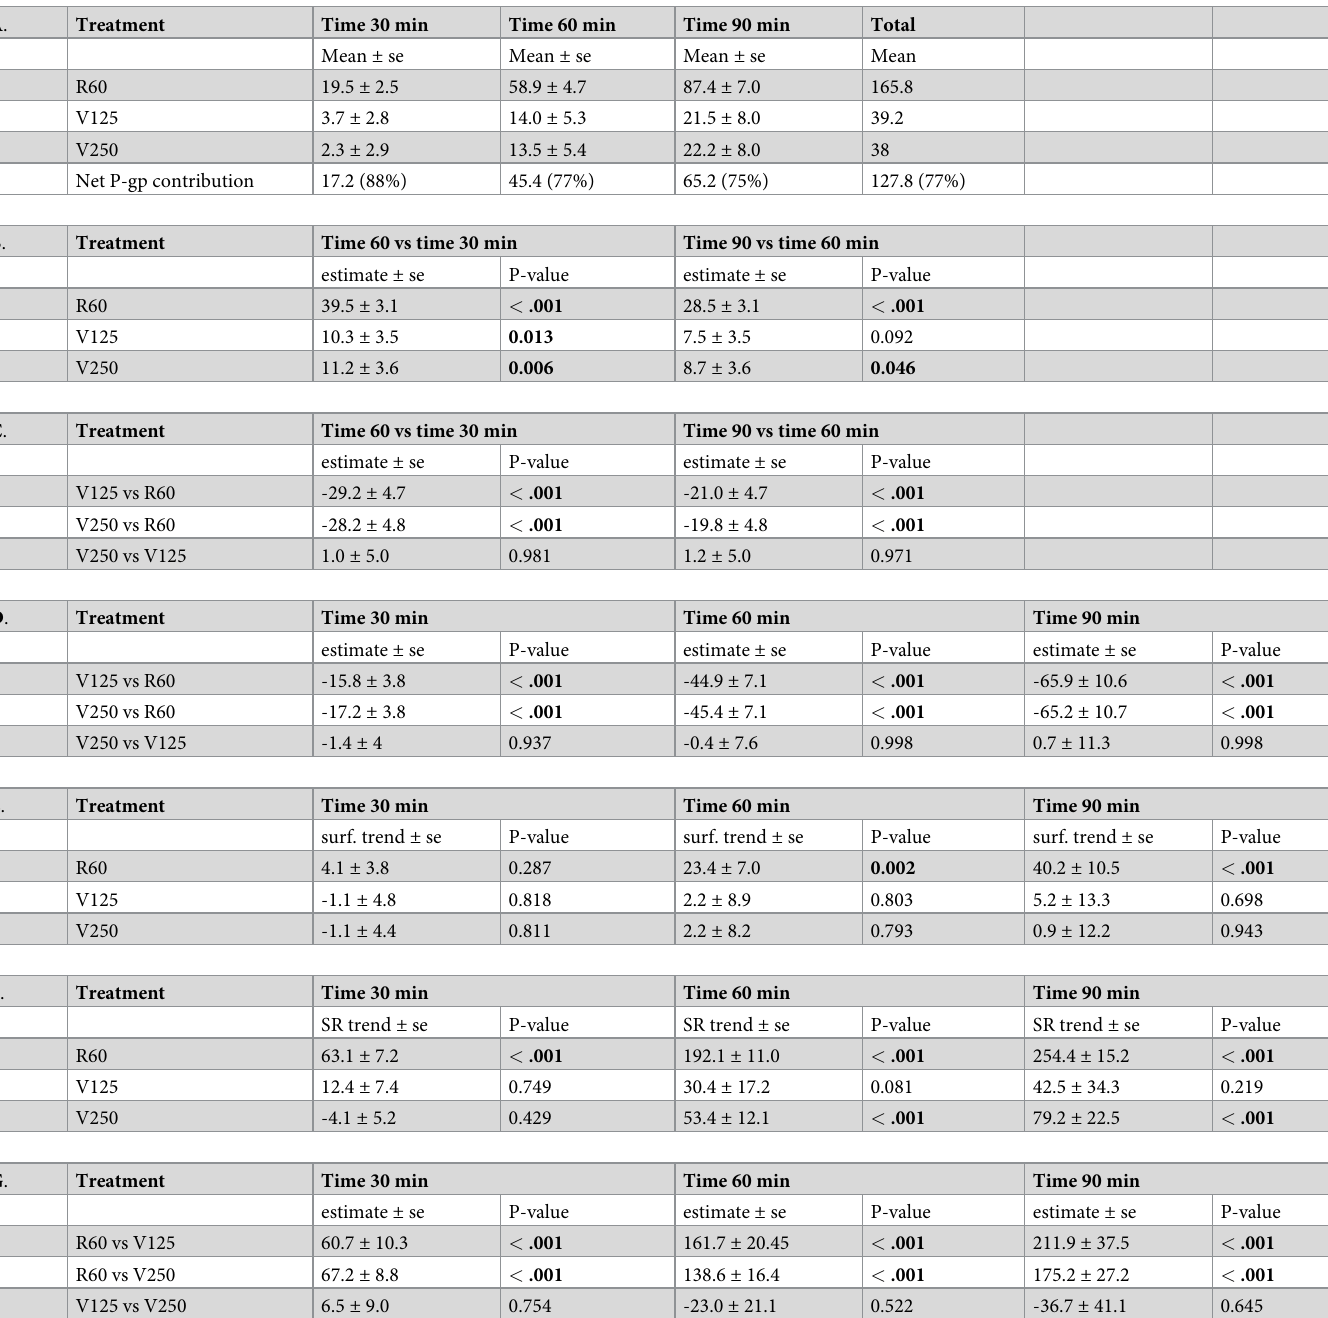
Table 3. Outcomes of a linear mixed model to investigate the effect of incubation time and treatment on the net quantity of rhodamine extruded (fmol/min) in the droplets secreted per minute. A